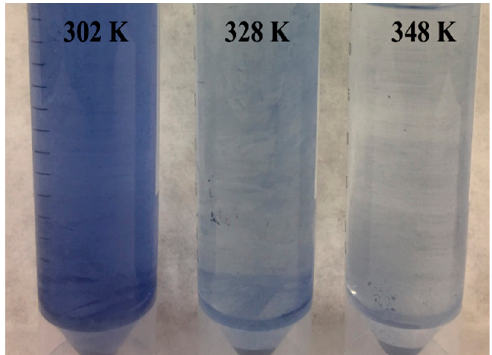
Figure 7. Effect of temperature for the adsorption of Direct Blue 78 onto eggshell at a concentration of 50 mg/L at different temperatures.